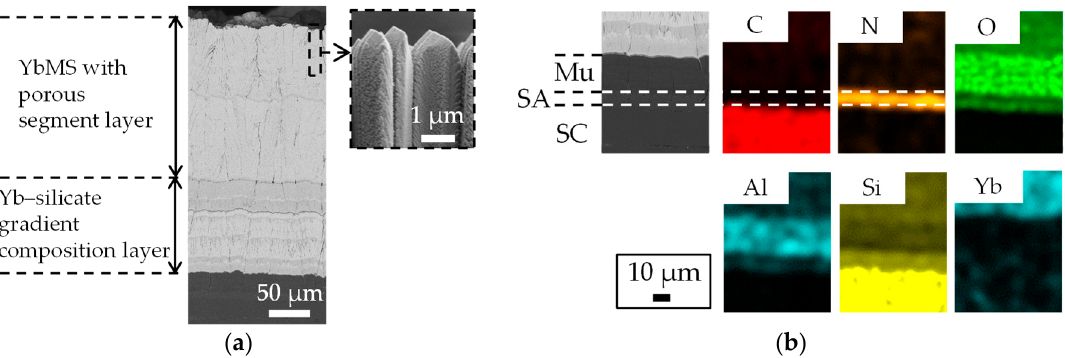
Figure 6. ( a ) Cross-sectional SEM images of T/EBC and ( b ) elemental mapping images focused on